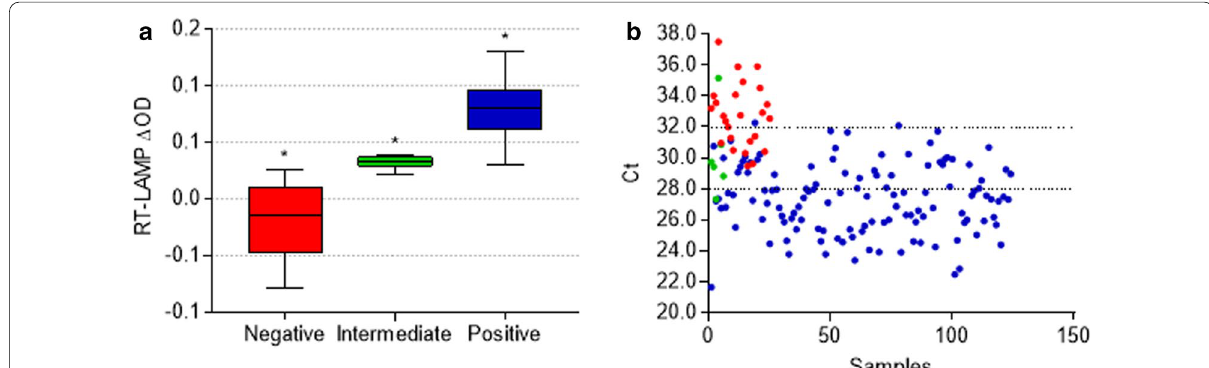
Fig. 3 RT-LAMP internal control results. a Colorimetric readout after 30 min of 18S internal control RT-LAMP reaction. Samples were pipette in a 384-well plate and the optical density was measured at 434 nm and 560 nm using a BioteK Synergy reader. To obtain the Δ OD (color change difference), absorbance at 560 nm was subtracted from the one at 434 nm. The line inside the box indicates the median and the whiskers extend either to the minimum and maximum values. * Indicates difference (p > 0.001) between groups (unpaired, t-test). b Detection of internal control 18S by RT-LAMP assay. Comparison between colorimetric RT-LAMP results and RT-qPCR CT values (RNAse P)